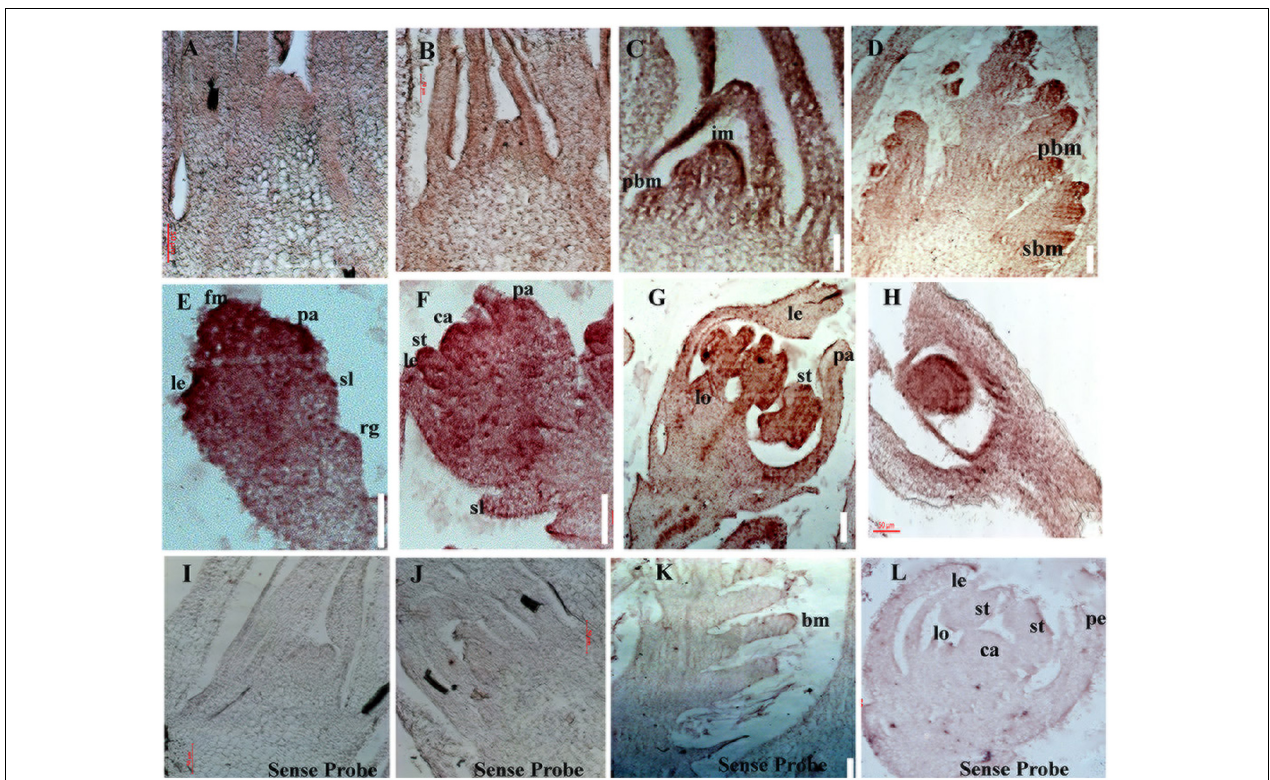
FIGURE 4 | Spatial distribution of OsbZIP47 transcripts in meristems and florets. (A,B) OsbZIP47 in situ RNA hybridization signal in SAM tissues from 5 DAG and 25 seedlings. Expression in SAM and in emerging leaf primordia. (C,D) Inflorescence meristem (IM) with emerging primary branch meristems show expression of OsbZIP47 in the elongation meristem and primary branch meristems (prb), secondary branch meristems (srb), and in young leaves. (E) OsbZIP47 transcripts in very early floret meristem (FM) with uniform spatial distribution of signal. (F) Floret uniform signal in the well-formed stamens (st), lemma/palea (le and pa) organ primordia, and in the central early carpel primordia. (G) High level of OsbZIP47 expression in the lodicule and in stamens, and lower signal in the near mature lemma and palea. (H) OsbZIP47 transcripts in the ovary wall and ovule. (I,J) SAM in 5 DAG and 25 DAG plants probe with sense probe as a negative control. (K,L) IM and near mature floret, respectively probed with sense